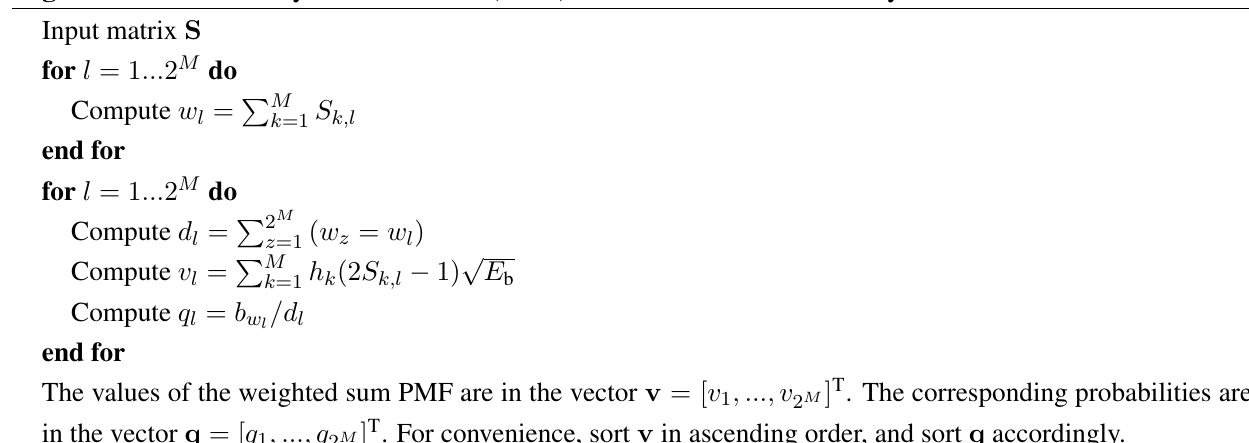
Algorithm 1 Probability mass function (PMF) of the noiseless received